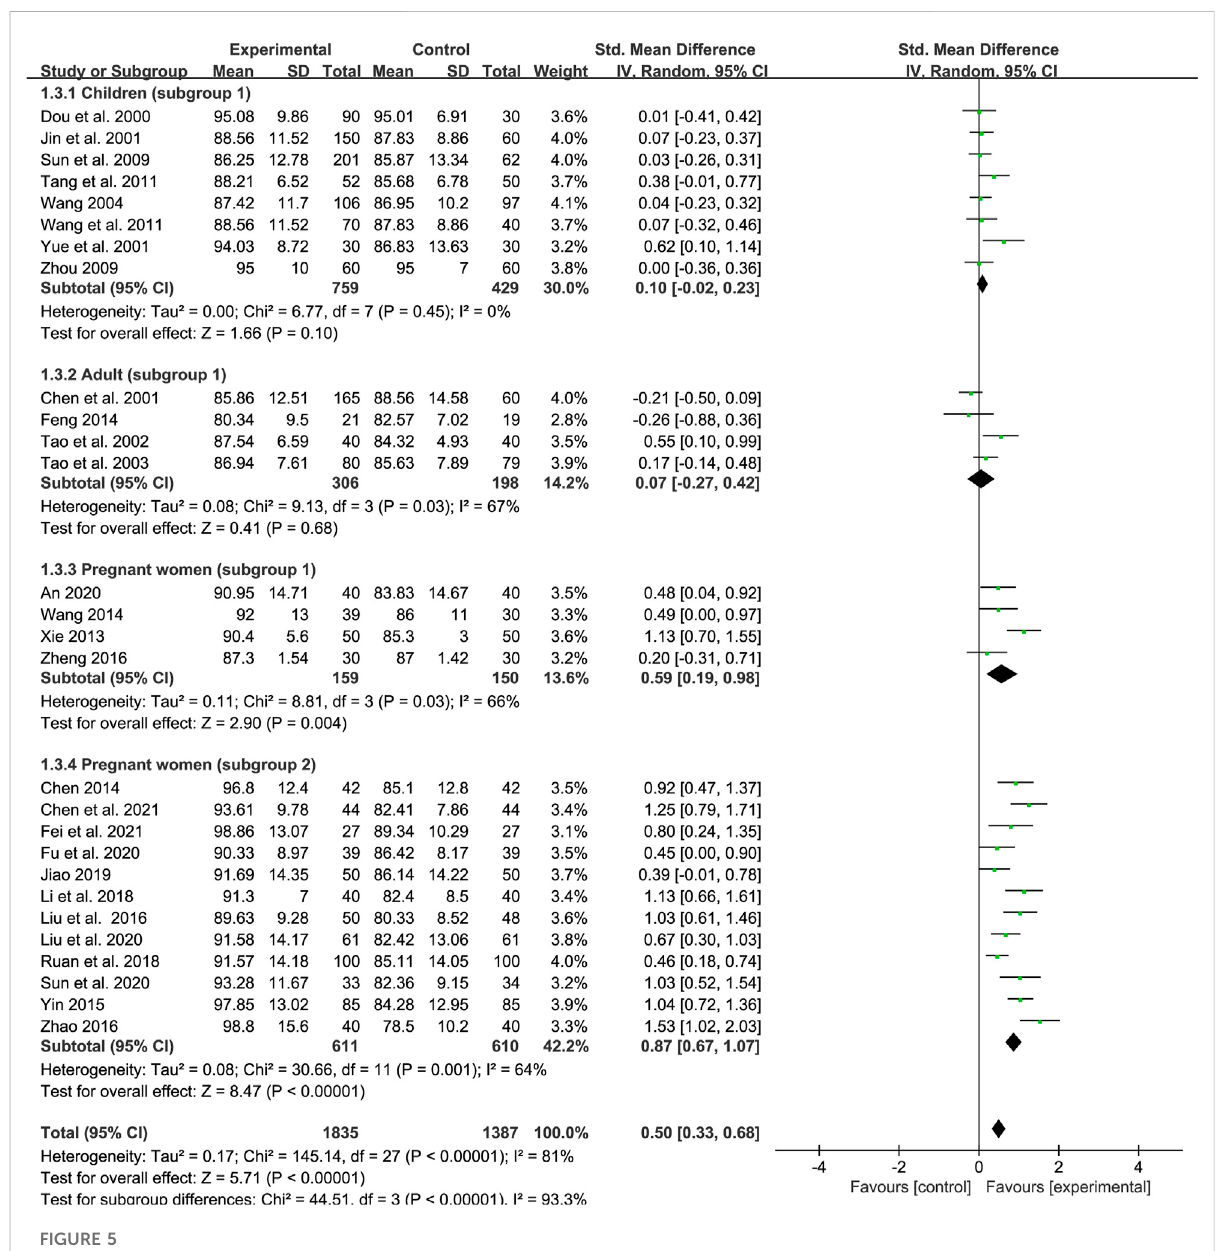
FIGURE 5 The forest plot assessing the effect of SXN on MCV